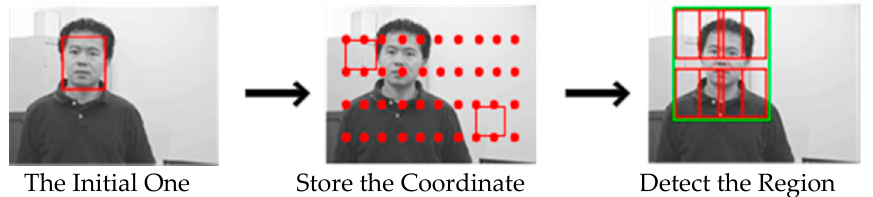
Figure 4. Brief process of generating the scanning grids and the region for detecting.